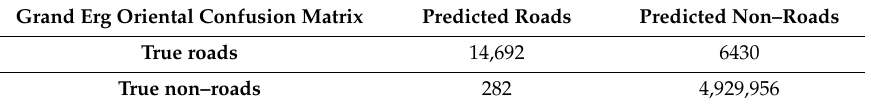
Table 6. Confusion matrix for true and detected roads calculated for same area as in Figures 12–14.